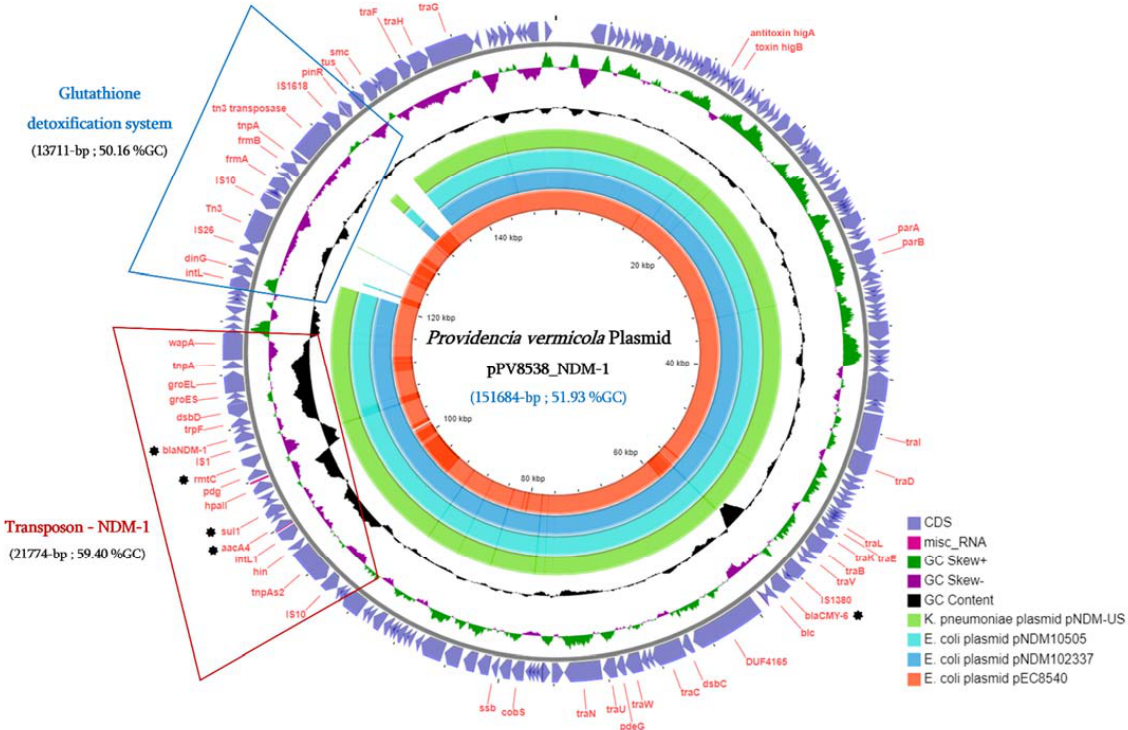
Figure 2. Comparison of the P. vermicola pPV8538_NMD-1 plasmid with E. coli pEC8540 plasmid and the three closest plasmids retrieved from the NCBI database.